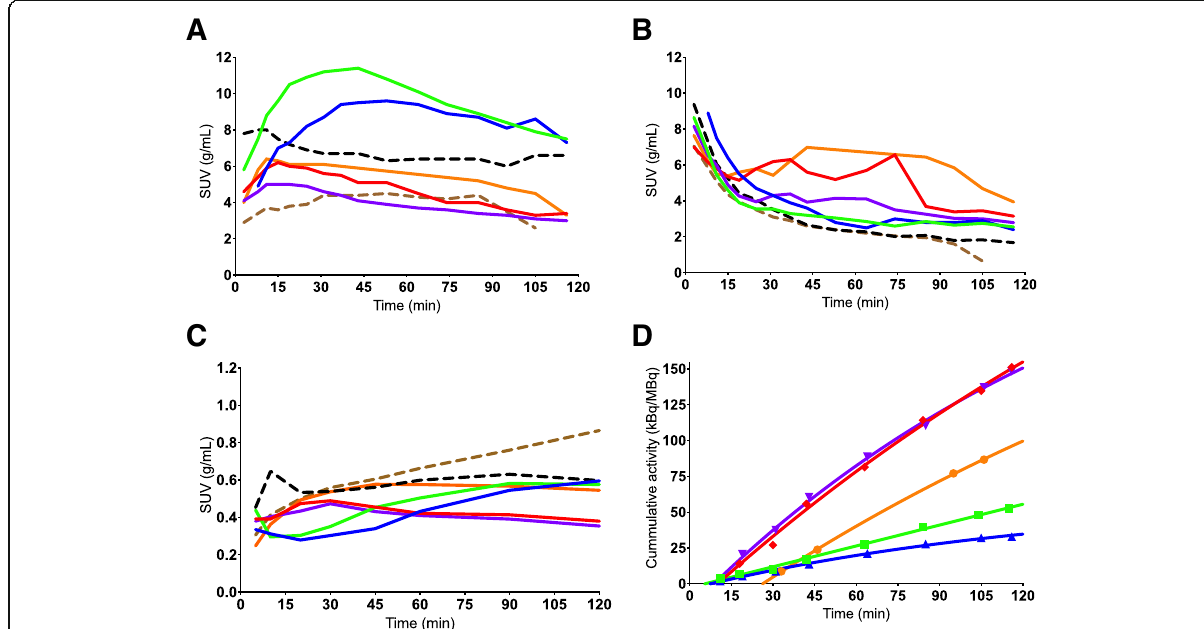
Fig. 3 Standard uptake value (SUV) curves for individual subjects for 11 C-Cimbi-36 (full lines) and 11 C-Cimbi-36_5 (dotted lines) in the liver ( a ), kidney ( b ) and whole blood ( c ). Decay-corrected cumulated activity (normalized to injected activity) in the bladder fitted with monoexponential function for 11 C-Cimbi-36 shows great variability in urinary excretion ( d ). Each color represents a single subject